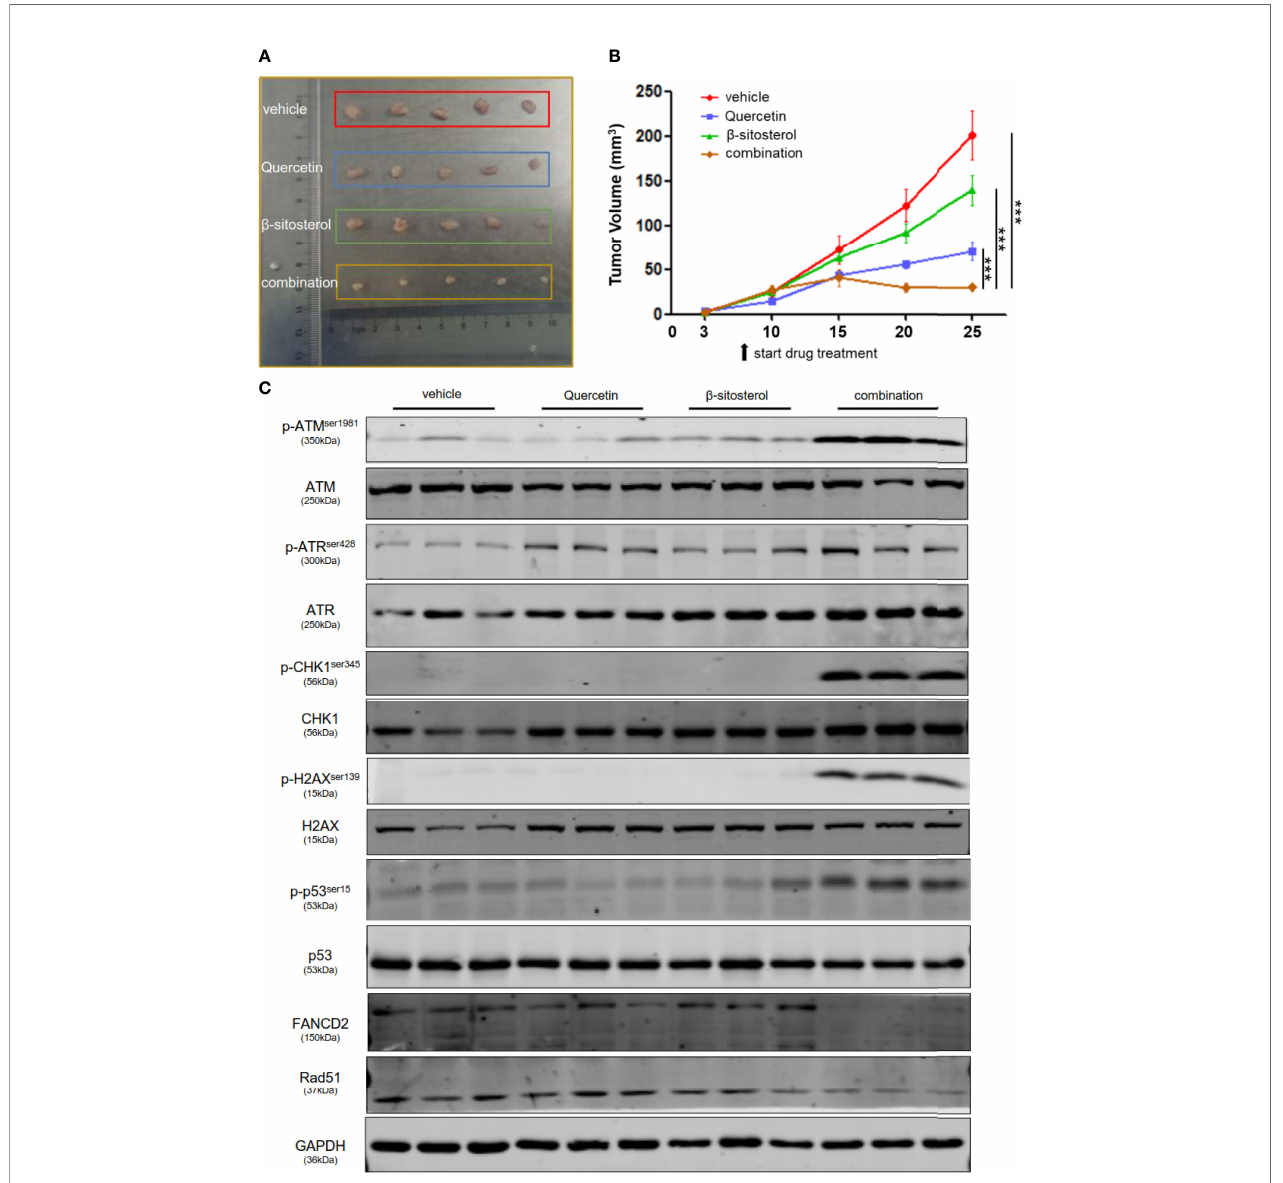
FIGURE 8 | Combination therapy leads to signi fi cant tumor regression in vivo . (A) Nude mice were subcutaneously injected with MDA-MB-231 cells. Representative images show the dissected tumors in distinct treatment groups as speci fi ed at the endpoint. (B) The tumor growth curve of xenografts treated with vehicle or quercetin or b -sitosterol or combination. The data presented as mean ± S.E.M. n = 5 for each group. ***P < 0.001 (one-way ANOVA, with Turkey ’ s multiple- comparison tests). (C) The tumor lysates were collected, and the protein profusion was established by immunoblotting